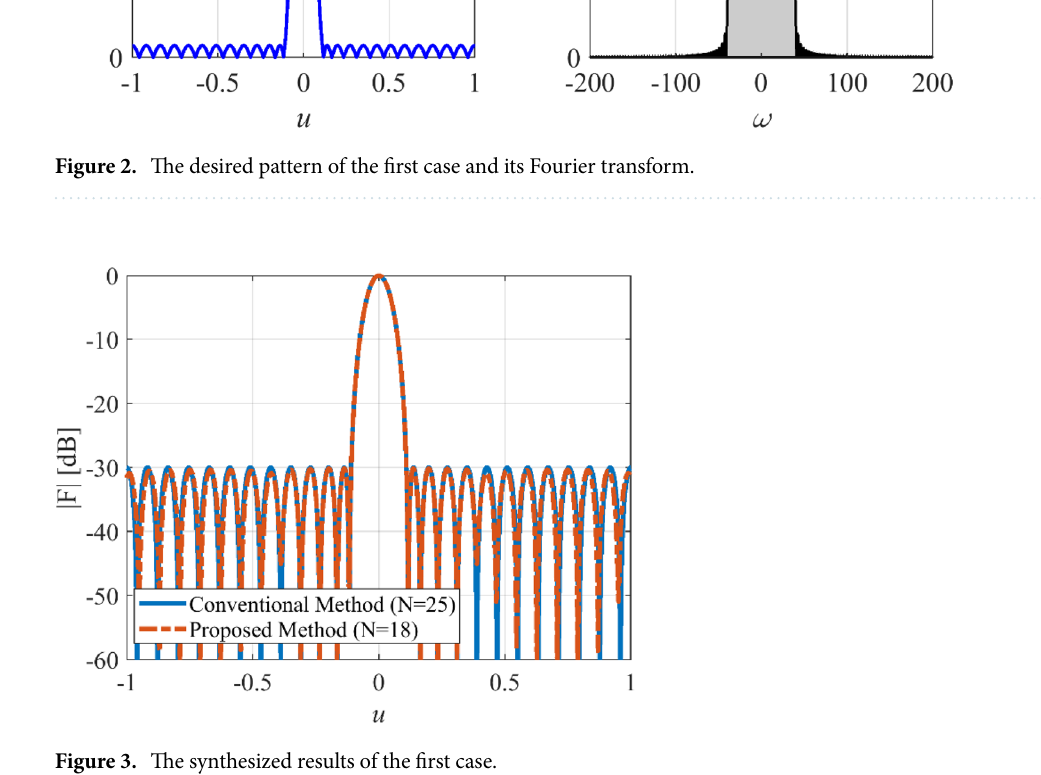
Figure 3. The synthesized results of the first case.